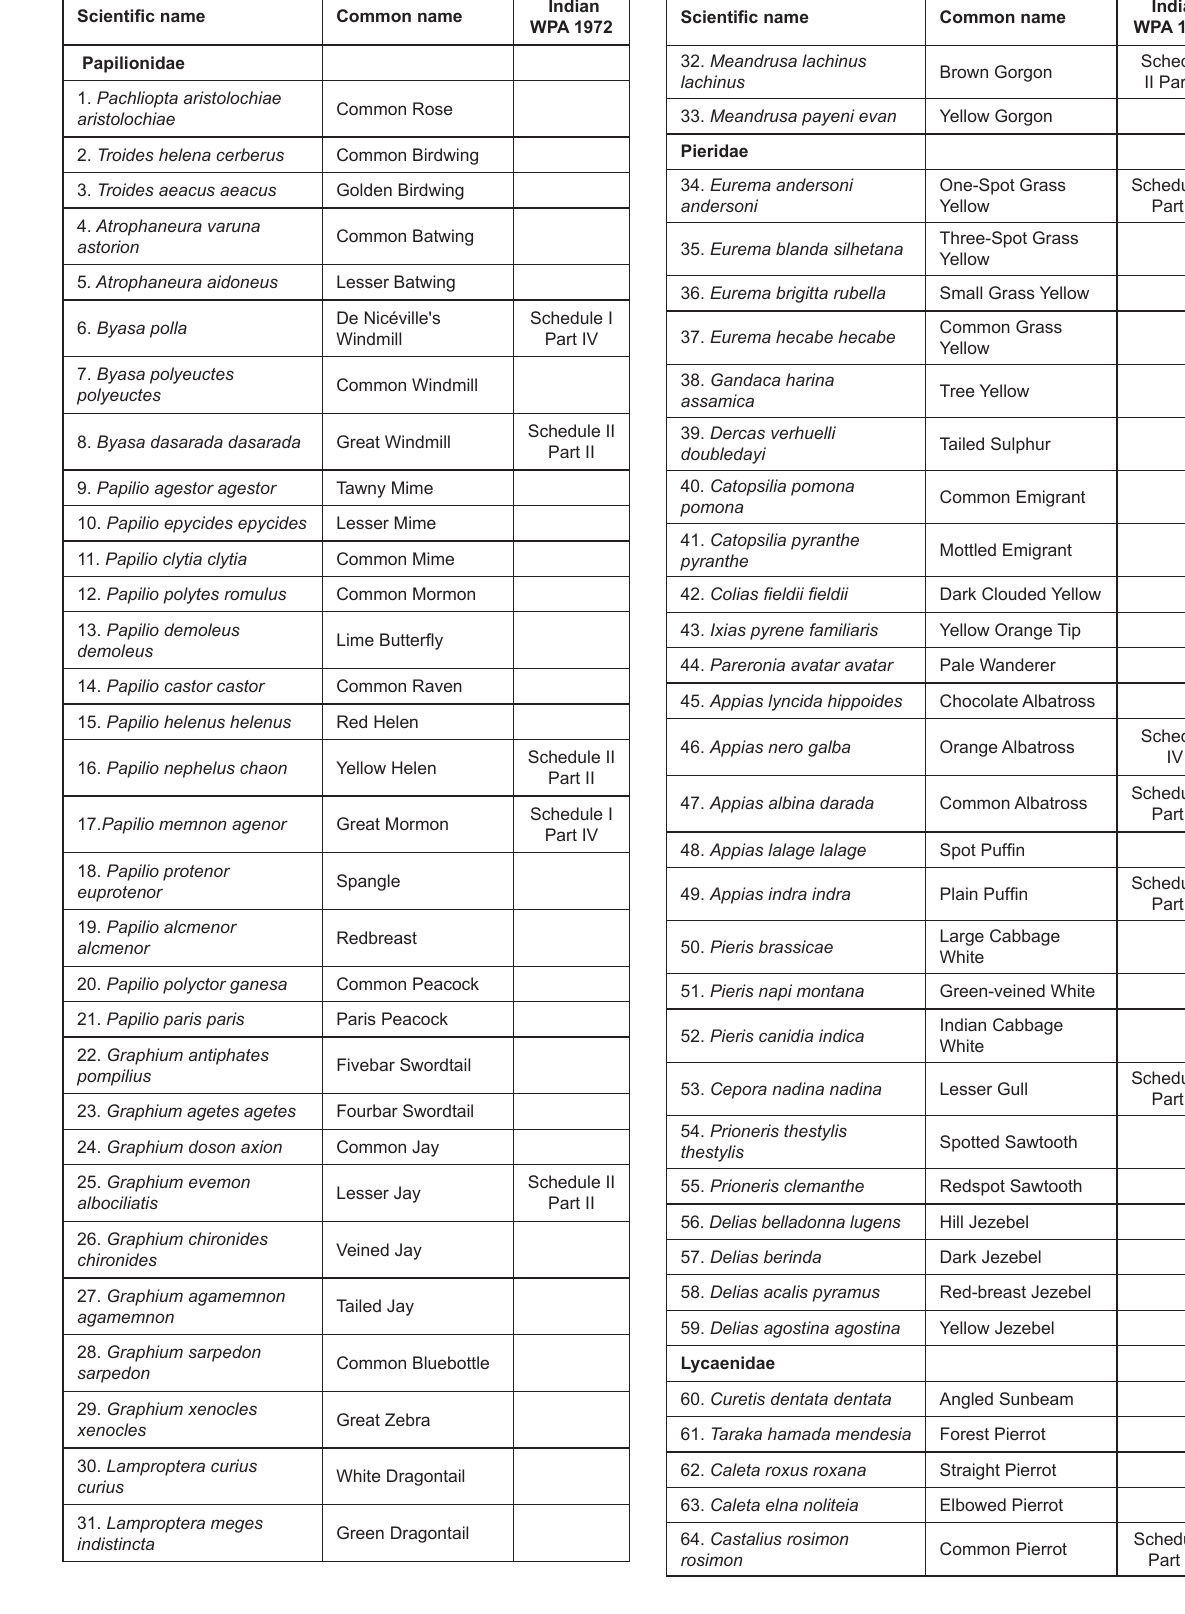
Table 1. Annotated list of butterflies recorded in the Mishmi Hills, Arunachal Pradesh during the study period (March–June